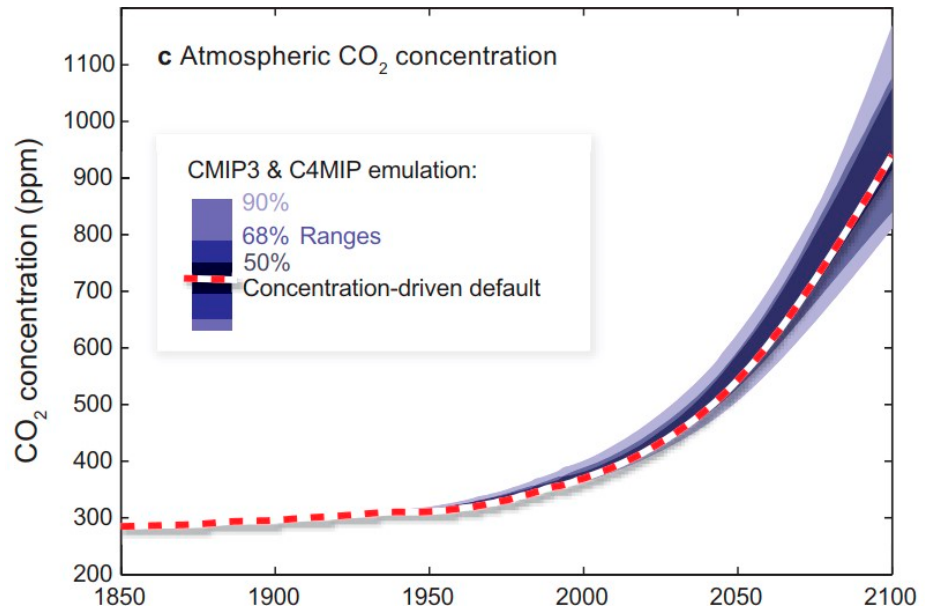
Figure 4. IPCC-predicted atmospheric carbon dioxide levels from IPCC 2013, Figure 12.36, Panel (c) [13]. Adapted with permission from Ref [13] Copyright 2013, The Intergovernmental Panel on Climate Change. Table 4. Cover required for 100 year life with 450 kg/m 3 cementitious material at 75% RH (700 ppm CO 2